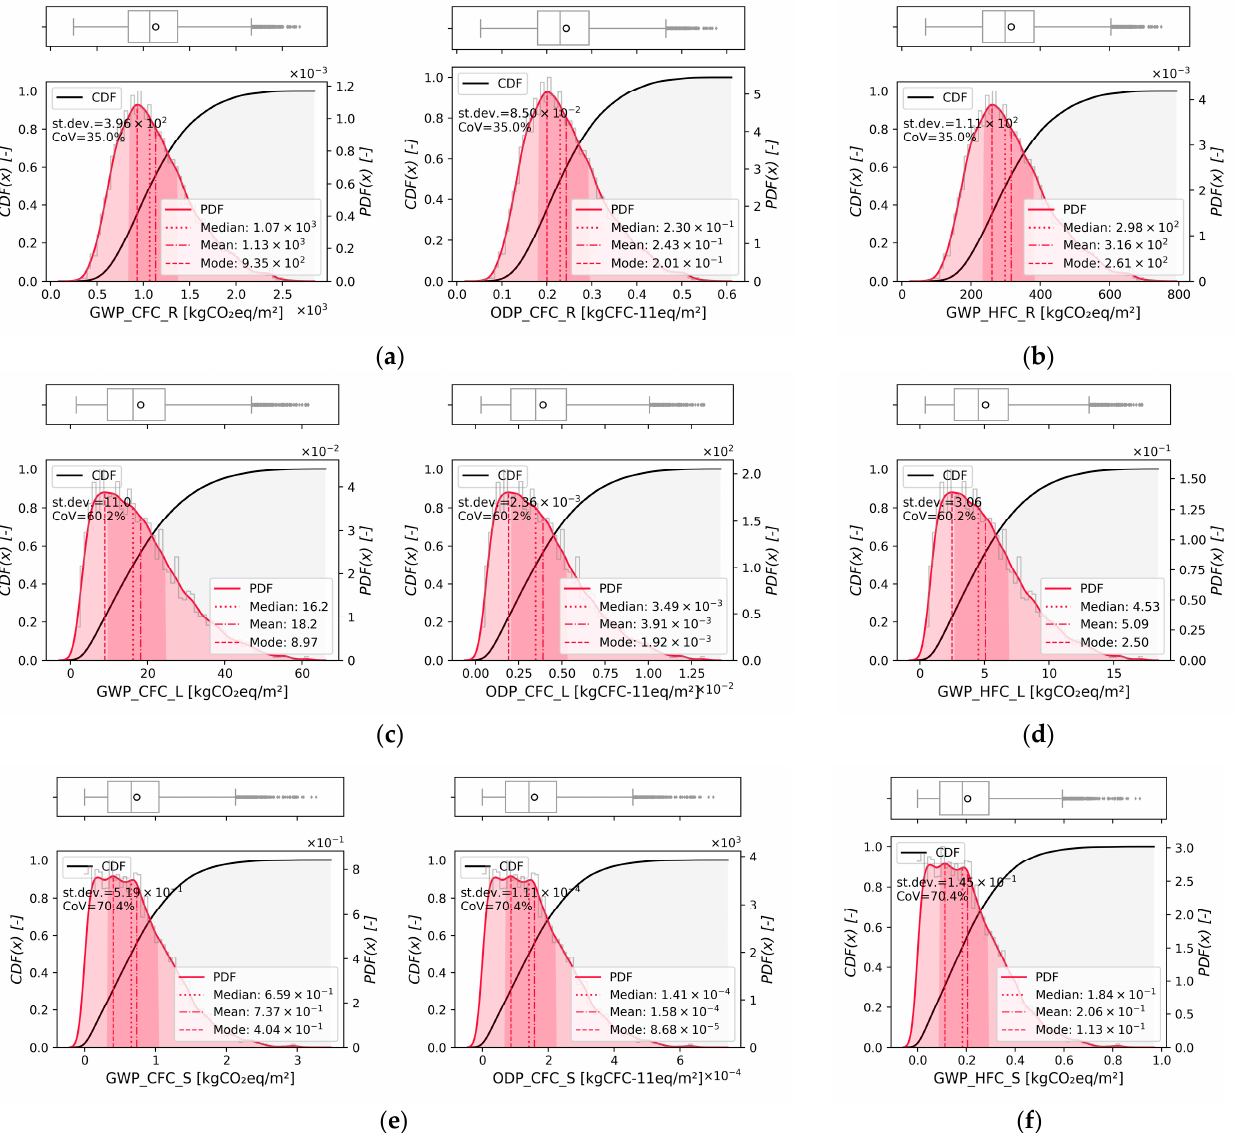
Figure 8. PDFs, CDFs, and box-whisker plots for the GWP and the ODP due to: residual content R tot